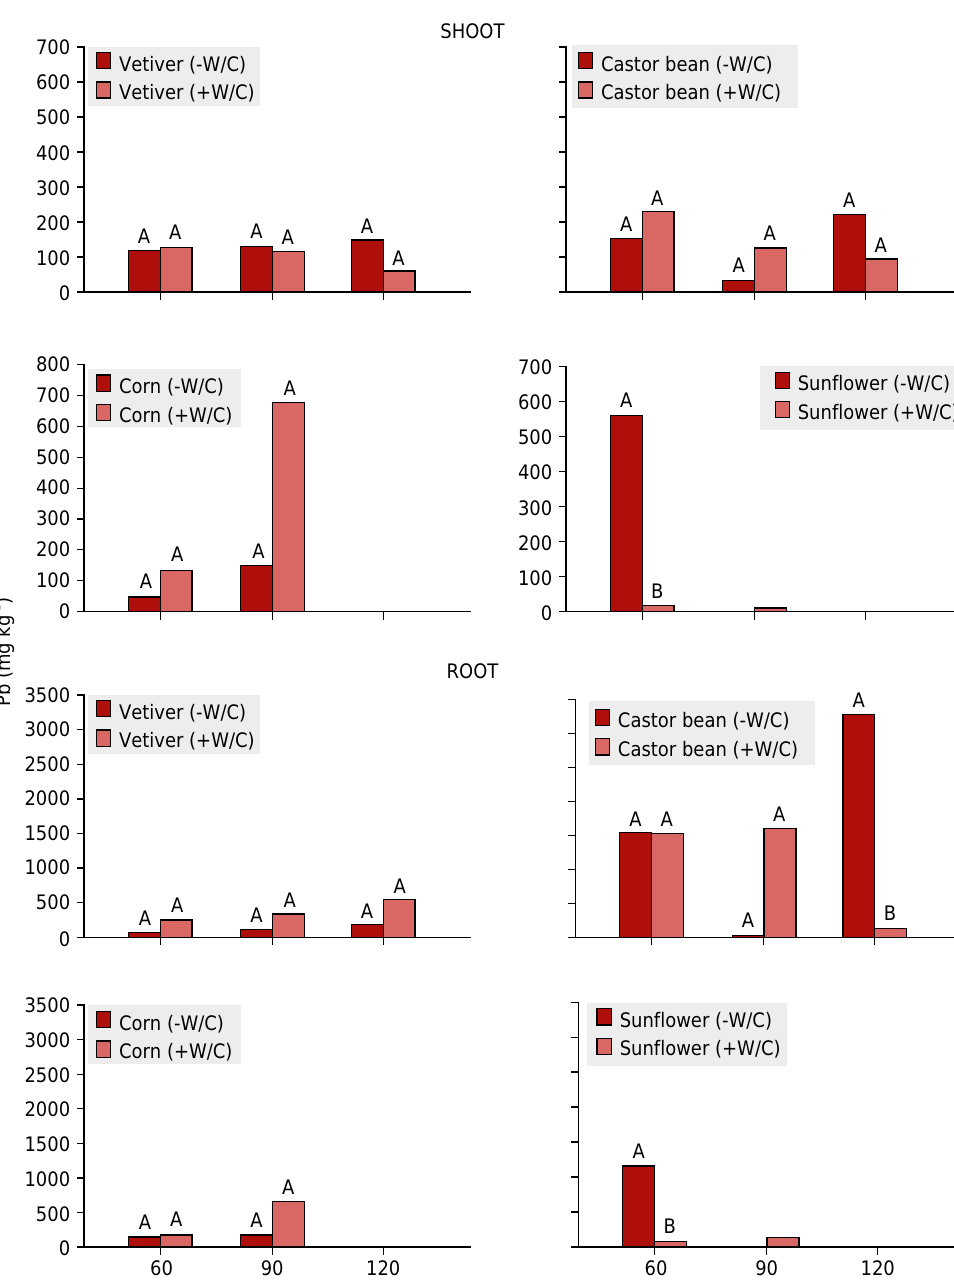
Figure 4. Lead contents in the shoots and roots in vetiver, castor bean, corn, and sunflower plants conducted in contaminated soil, without (-W/C) and with (+W/C) correction of soil pH, at 60, 90, and 120 days after planting (DAP). Means followed by the same letter, within each period, do not differ among